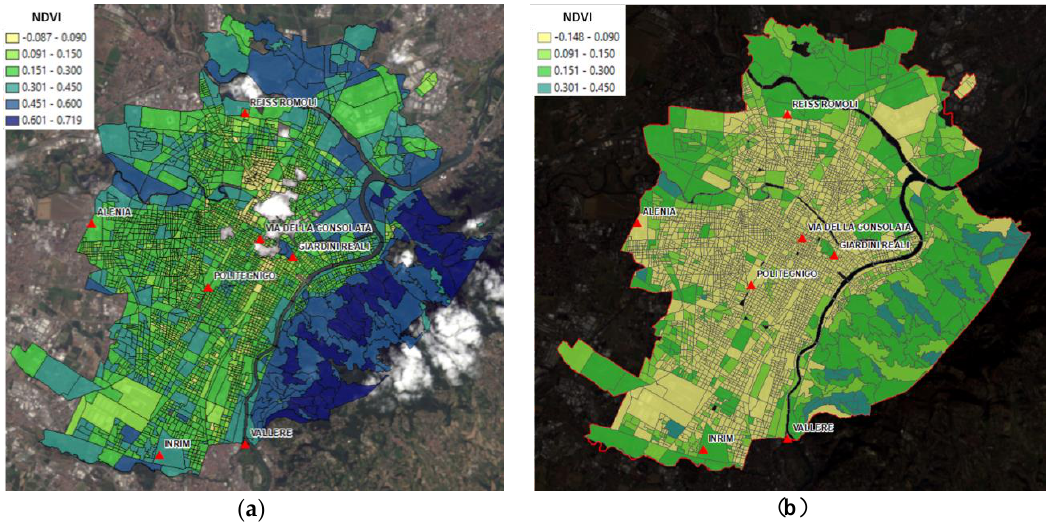
Figure 11. NDVI from Landsat 8: ( a ) 25 August 2016; ( b ) 21 January 2016.